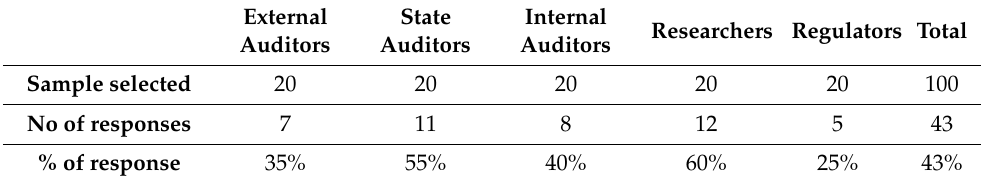
Table 2. Participants’ Groups